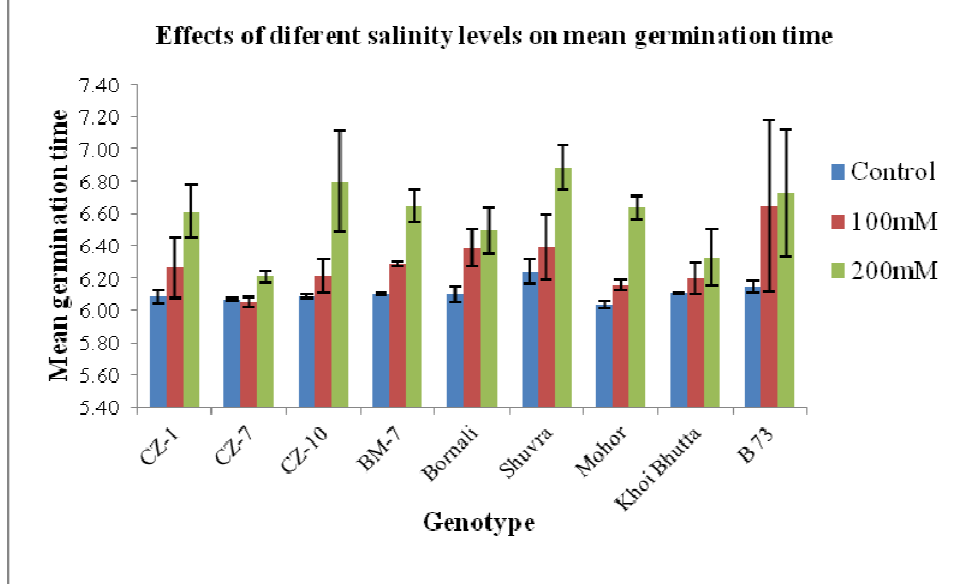
Fig. 4. Effects of different salinity levels on mean germination